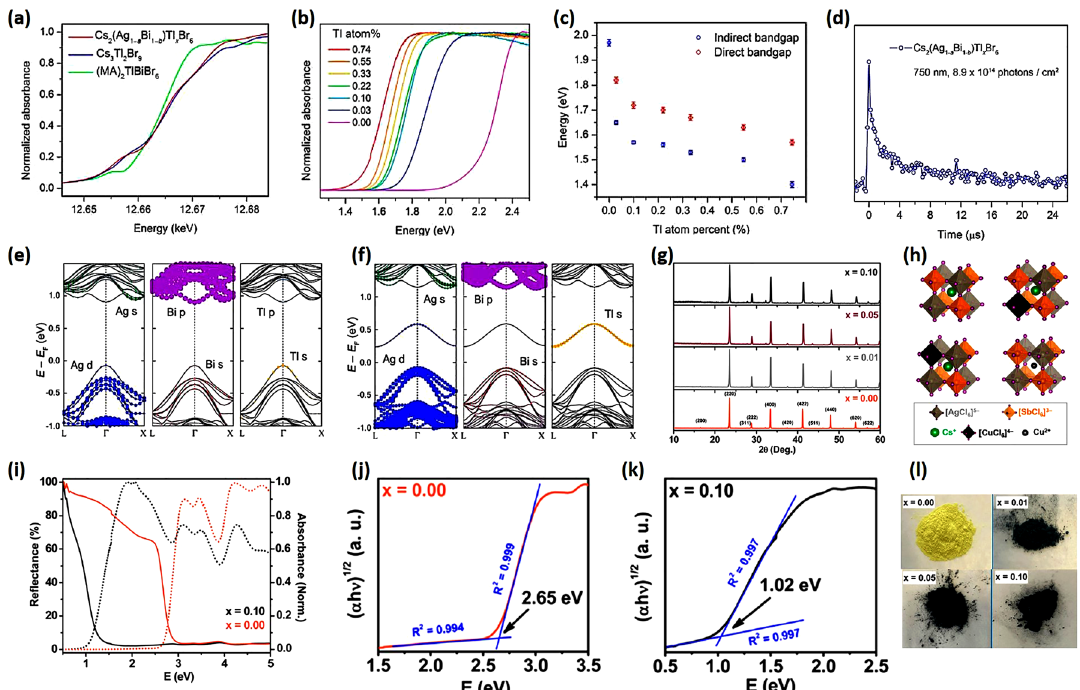
Figure7: (a)X-raynearedgeabsorptionstructure(XANES)spectrumofCs 2 (Ag 1 − a Bi 1 − b )Tl x Br 6 ( x =0.075),Tl + andTl 3 + standards[132].Copyright 2017, American Chemical Society. (b) Absorbance spectra of Cs 2 (Ag 1 − a Bi 1 − b )Tl x Br 6 [132]. Copyright 2017, American Chemical Society. (c) ApparentbandgapsofCs 2 (Ag 1 − a Bi 1 − b )Tl x Br 6 .(d)TRMCdecaytraceofCs 2 (Ag 1 − a Bi 1 − b )Tl x Br 6 (with x =0.075)single-crystals[132].Copyright2017,